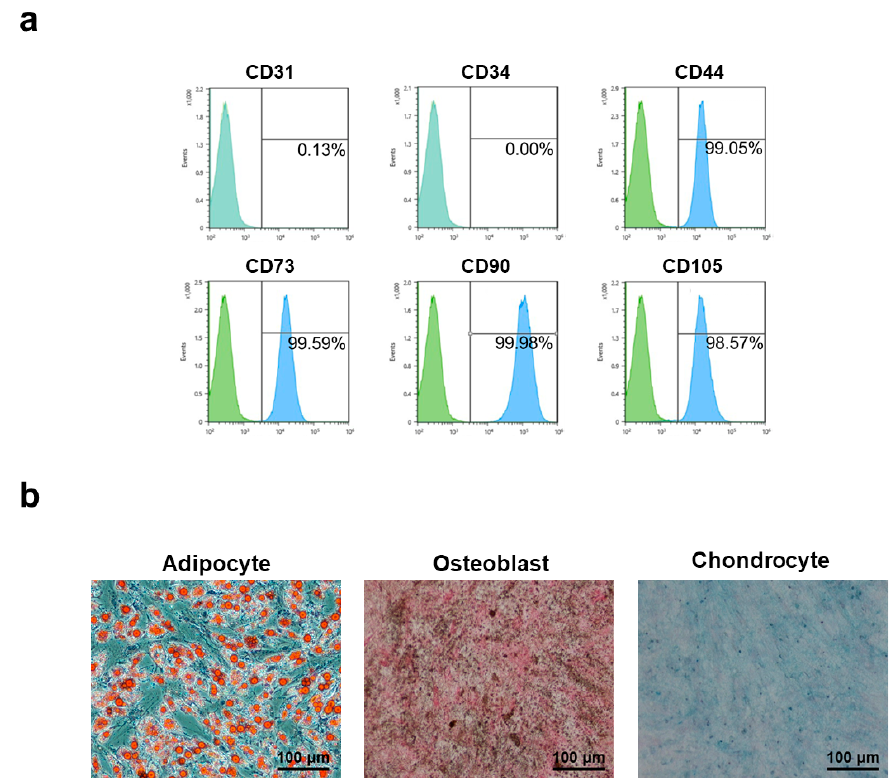
Figure 2. Characterization of adipose-derived mesenchymal stem cells (AD-MSCs) used for experiments. ( a ) Positive markers for CD44, CD73, CD90, and CD105, negative markers for CD31 and CD34; ( b ) Staining for multilineage differentiation of AD-MSCs.